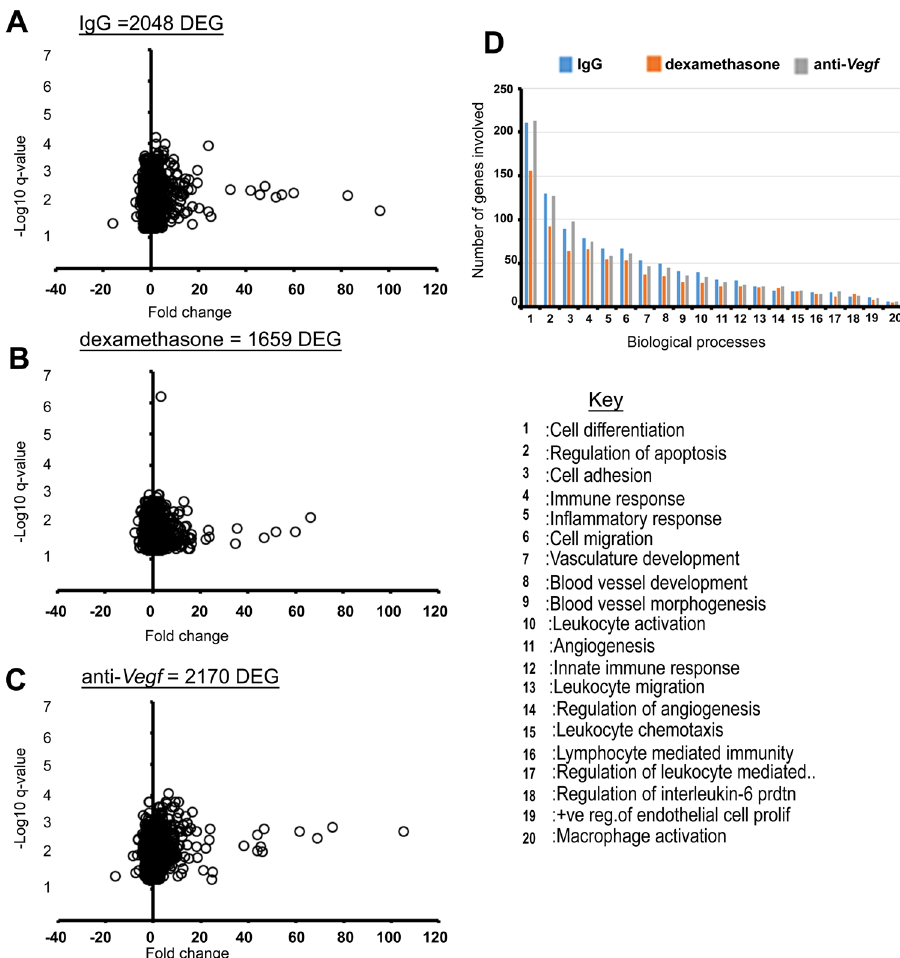
Figure 2. Differentially expressed genes (DEGs) in IgG, dexamethasone and anti- Vegf treated groups, and selected enriched biological processes. ( A–C) Volcano plots of the DEGs in IgG, dexamethasone and anti- Vegf groups respectively. (D) Selected biological processes of interest, indicating the number of DEGs involved in the processes for each